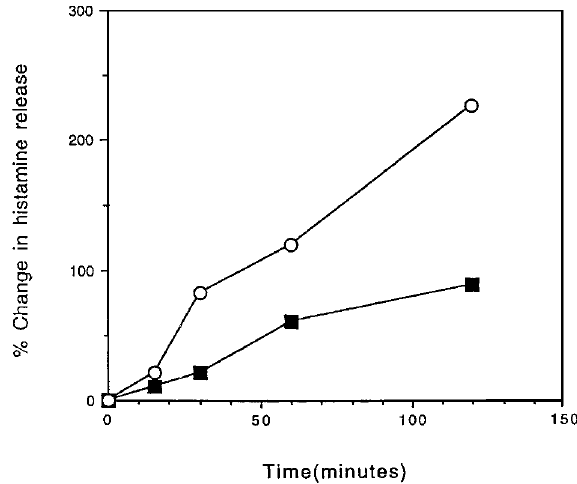
FIG. 2. IgE-mediated histamine release in nasal mucosa at various concentration, 7.5 m M ( – d – ) and 150 m M, ( – m – ) of SLPI compared with spontaneously released histamine (– h –). SLPI had no influence on spontaneous histamine release.